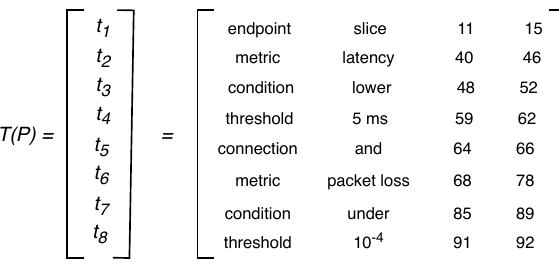
Figure 5. Matrix T for policy P .